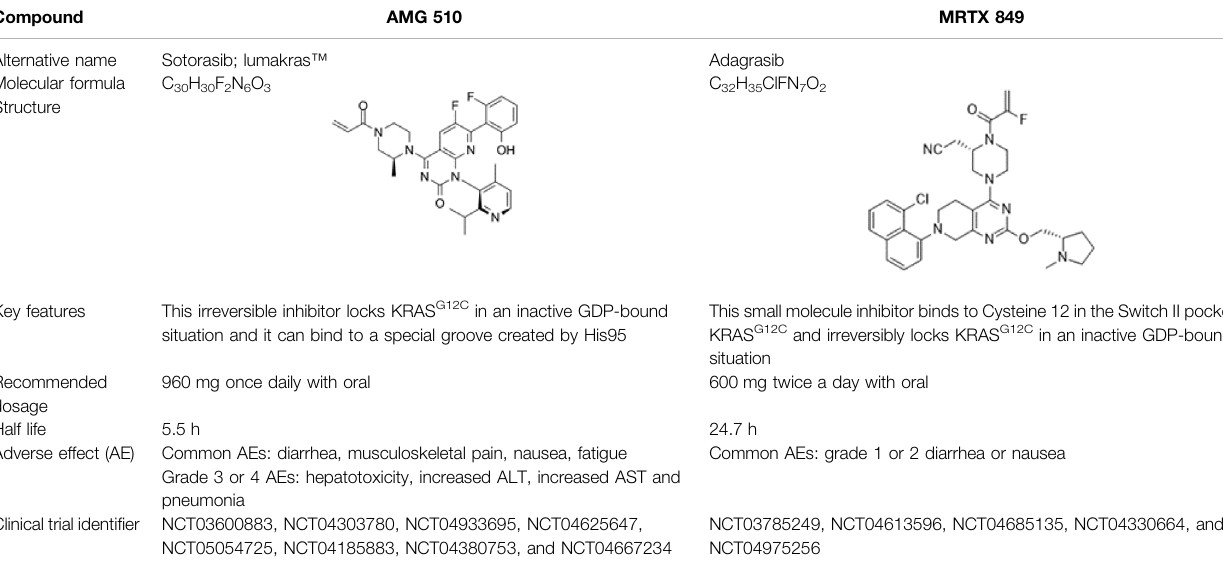
TABLE 1 | Comparison between AMG 510 and MRTX